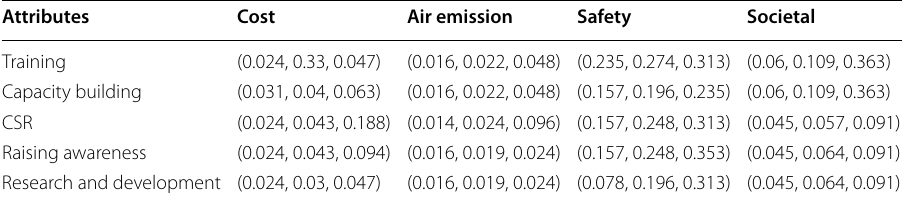
Table 18 Weighted normalised fuzzy decision matrix